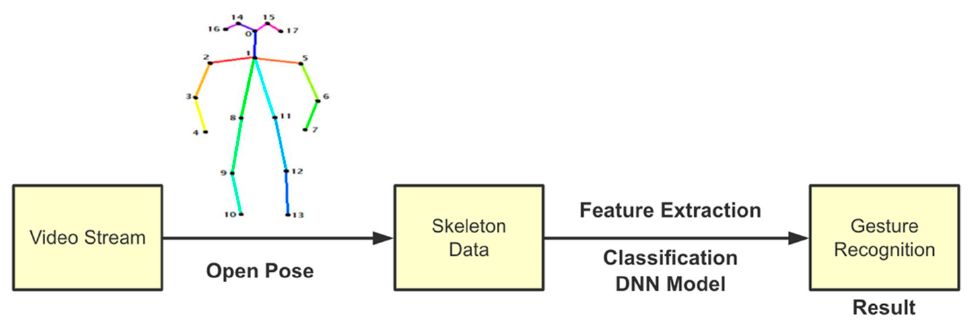
Figure 5. Workflow of the human body gesture recognition.